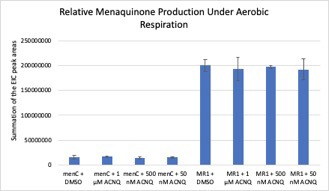
Menaquinone analysis of S. oneidensis menC::Tn10 (menC) and S. oneidensis MR-1 (MR-1) cell pellets when grown with 0.05, 0.5, and 1 μM of ACNQ supplemented to the media under aerobic conditions.No evidence of ACNQ being converted to menaquinone or being prenylated to form an amino-modified menaquinone was observed.